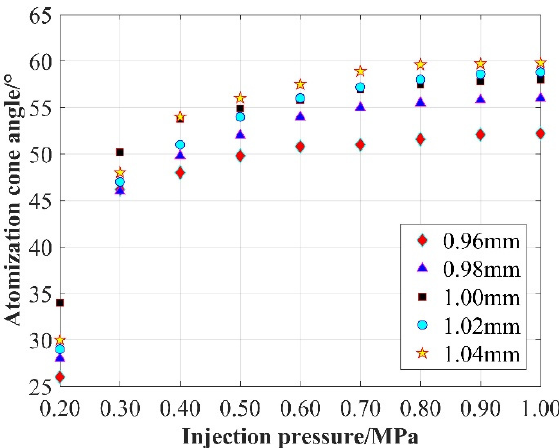
Figure 14. The relationship between the atomization cone angle and colliding aperture and jet pres-